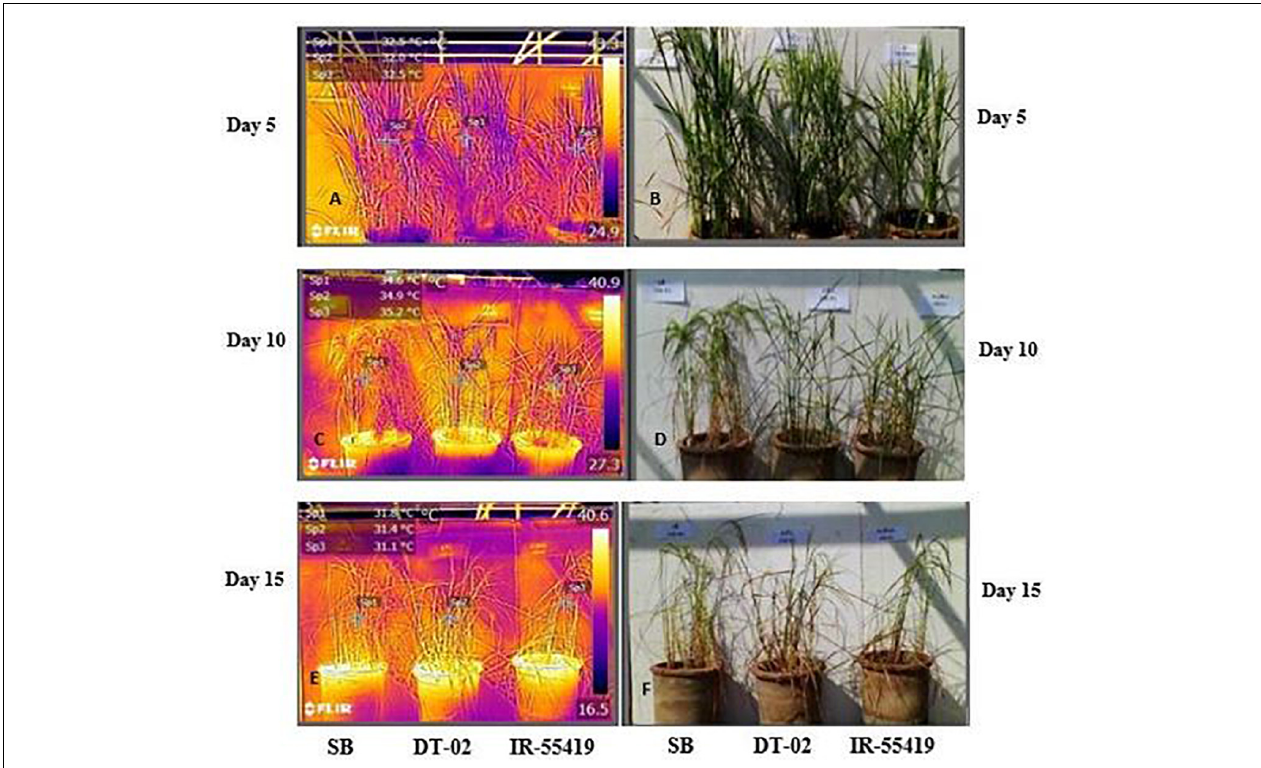
FIGURE 4 | Visual and infrared thermal images of rice genotypes taken by a FLIR T-E6 camera in a net house pot experiment. Genotypes: SB, NIBGE-DT-02, IR-55419-04. (B,D,F) Visual images of plants taken at day 5, 10, and 15 after water stress. (A,C,E) Thermal images of plants taken at day 5, 10, and 15 after water